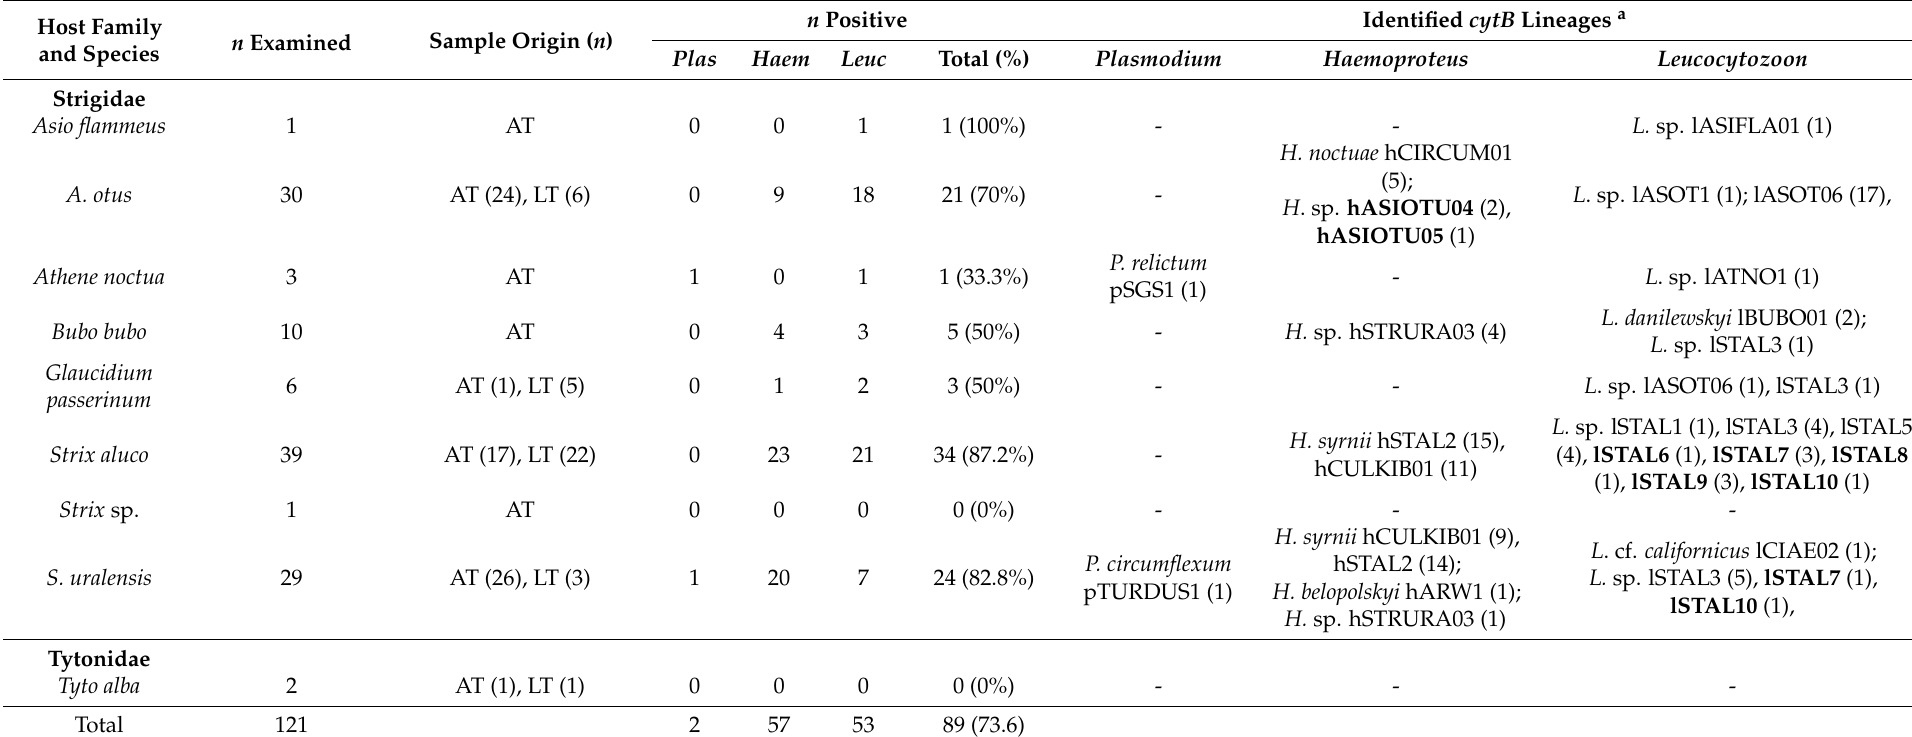
Table 1. Haemosporidian parasites and cytB lineages recorded in species of Strigiformes by PCR and